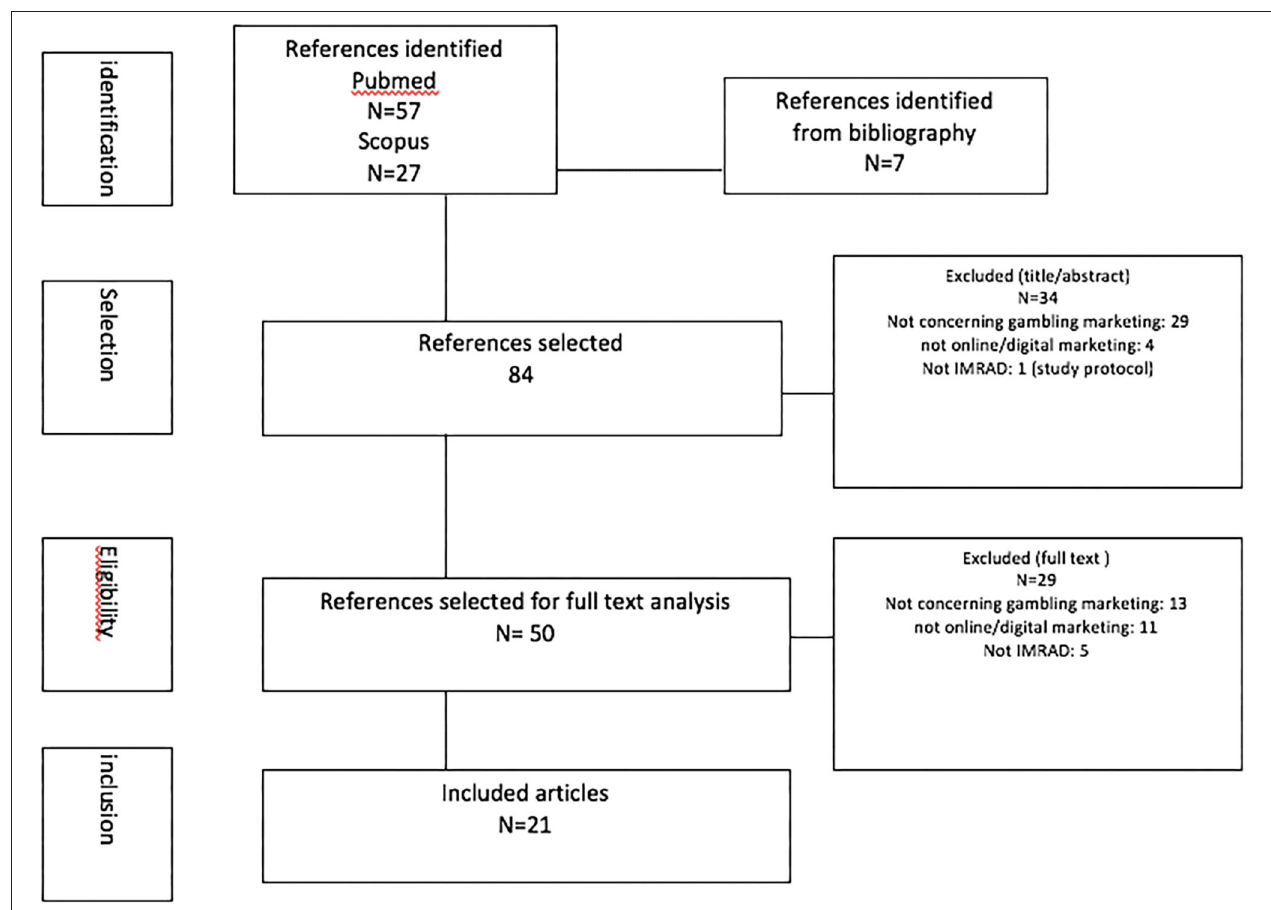
FIGURE 1 | PRISMA